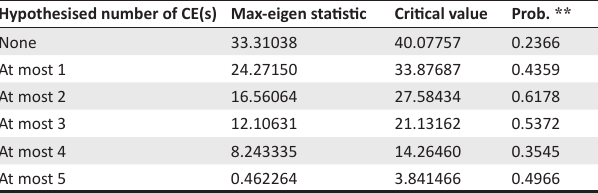
TABLE 7: Johansen co-integration test – maximum eigenvalue: Unrestricted co-integration rank test (maximum eigenvalue). Hypothesised number of CE(s) Max-eigen statistic